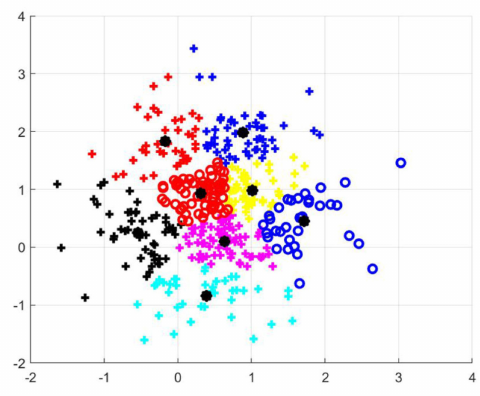
Figure 2. K-means clustering method